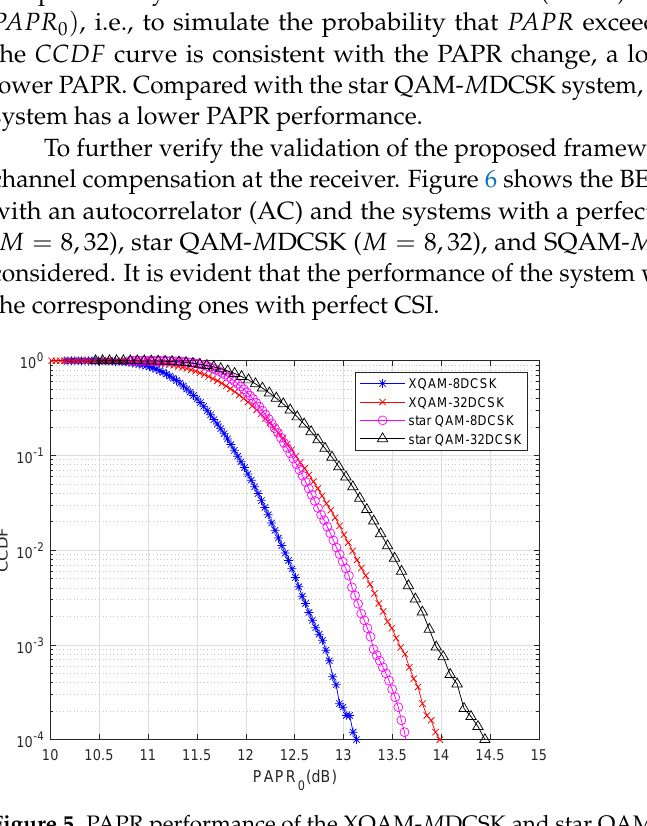
Figure 5. PAPR performance of the XQAM- M DCSK and star QAM- M DCSK systems.